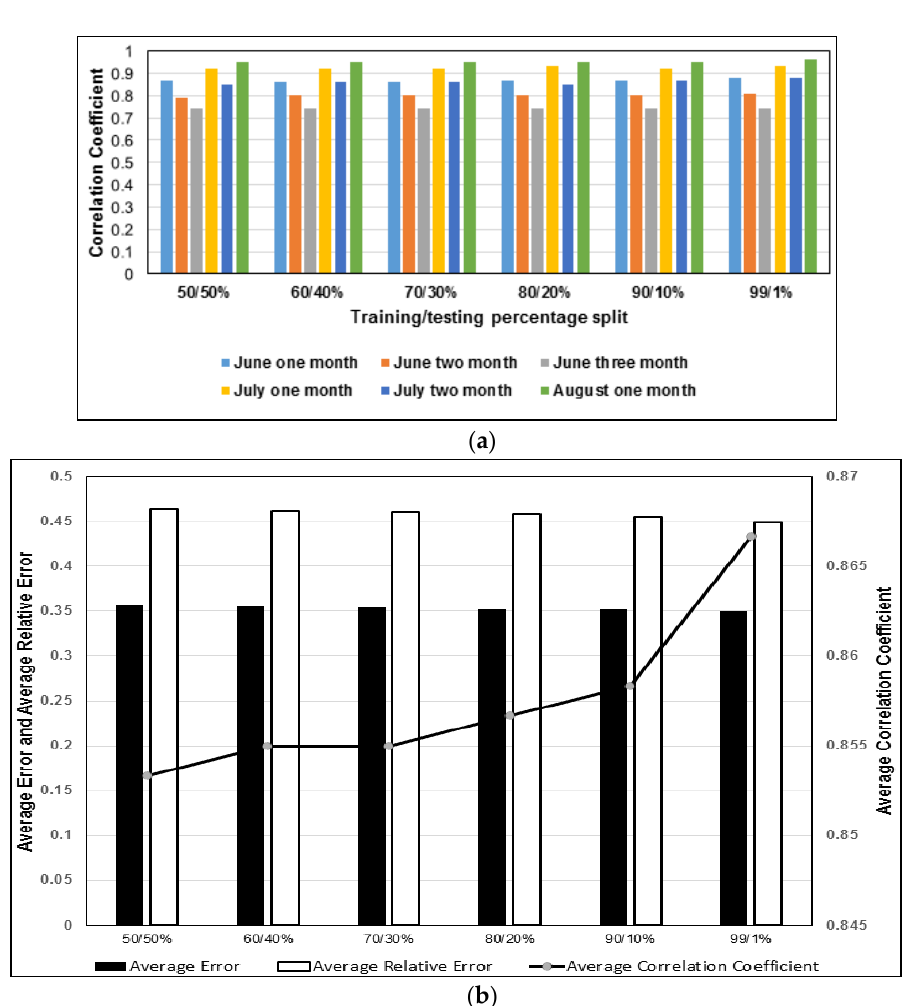
Figure 7. Percentage split comparisons for the training and testing; ( a ) monthly models comparisons; ( b ) average performances evaluations for MAD, RE, and CC.